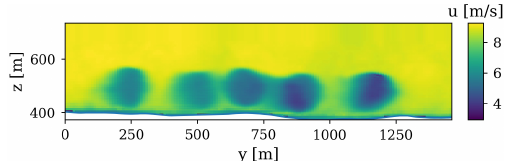
Figure 3. Streamwise velocity contours showing a plane perpen- dicular to the predominant wind direction.